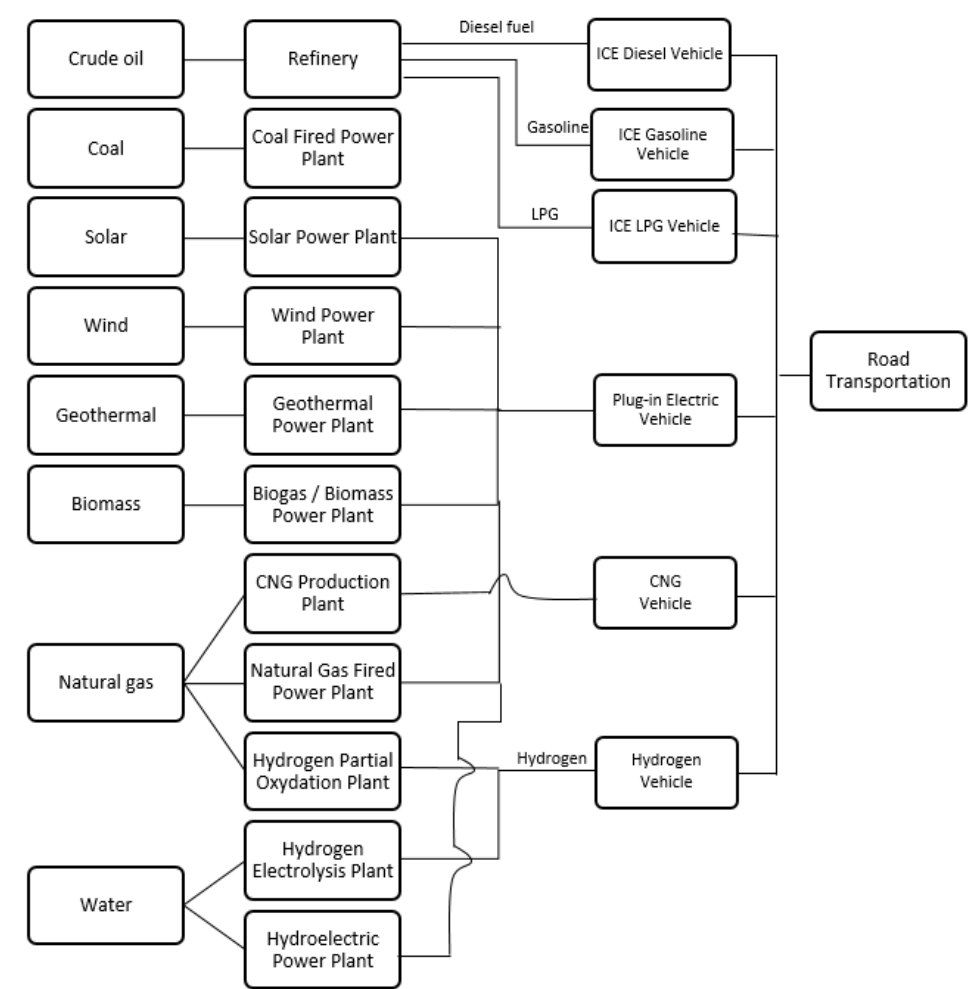
Figure 1. Partial view of Bottom-Up Energy Modeling System’s (BUEMS’s) Reference Energy